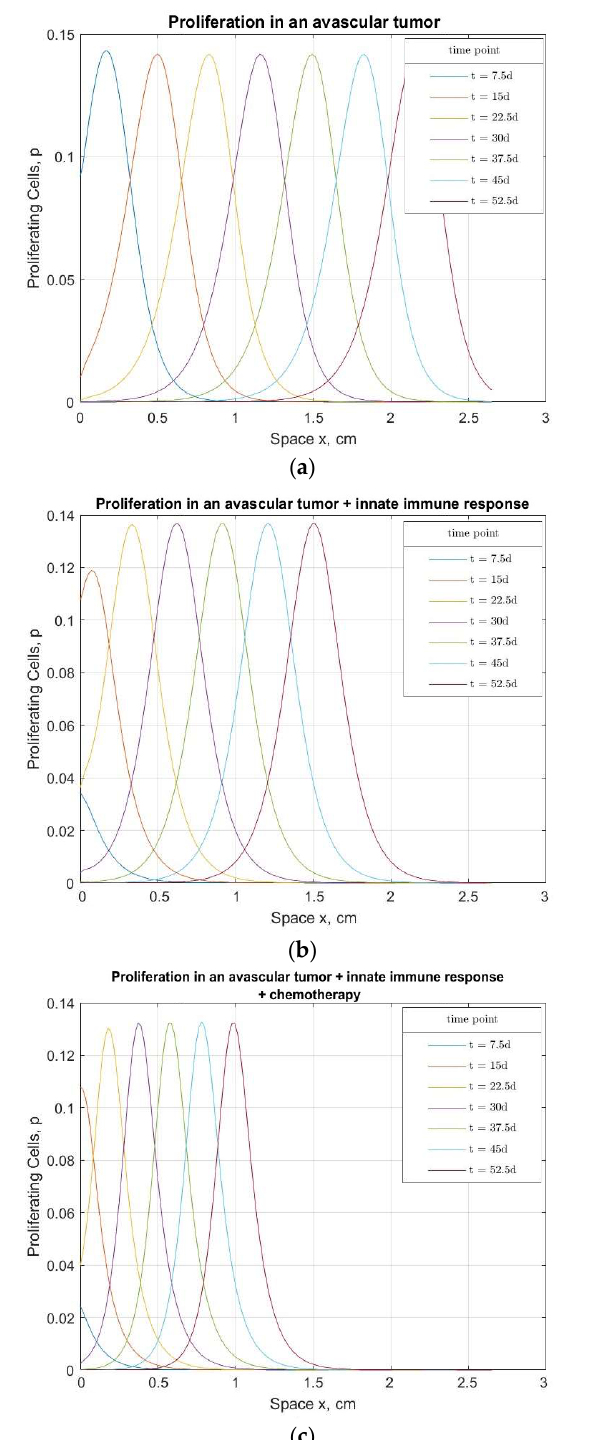
Figure 1. Numerical solutions for the proliferating cell density of an avascular tumor ( a ) without extratumoral interactions, ( b ) with the response of the innate immune system, ( c ) with the response of the innate immune system under the effect of chemotherapy, as functions of space x at times t = 0…52.5 days.